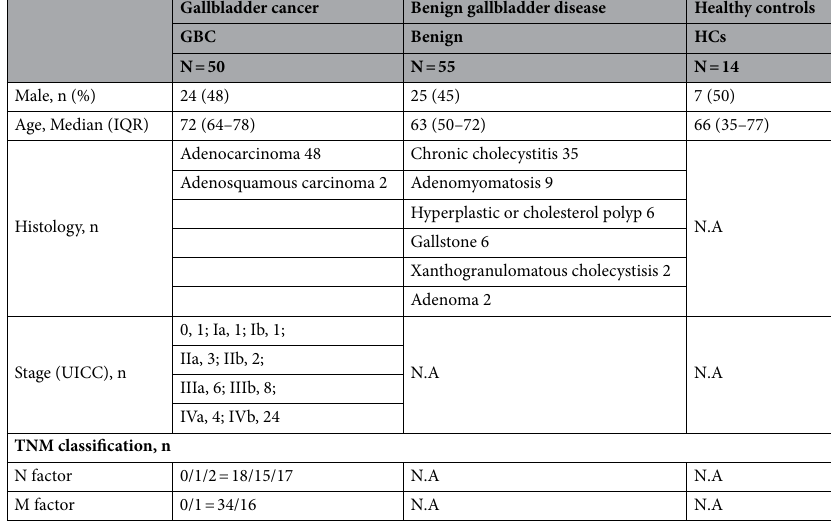
Table 1. Patient Characteristics. UICC, Union for International Cancer Control. IQR, Interquartile range; N.A., not